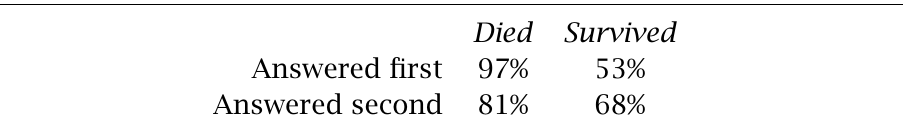
Percentages of positive answers by question and order for ques- tions (i) and (ii)